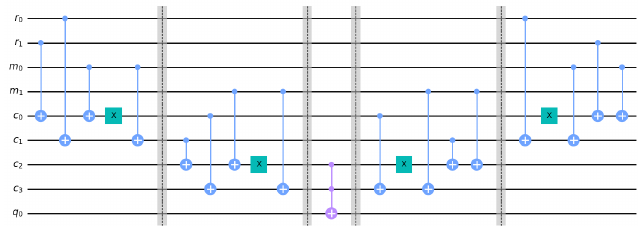
Figure 10. Implementation of oracle with the M and T quantum